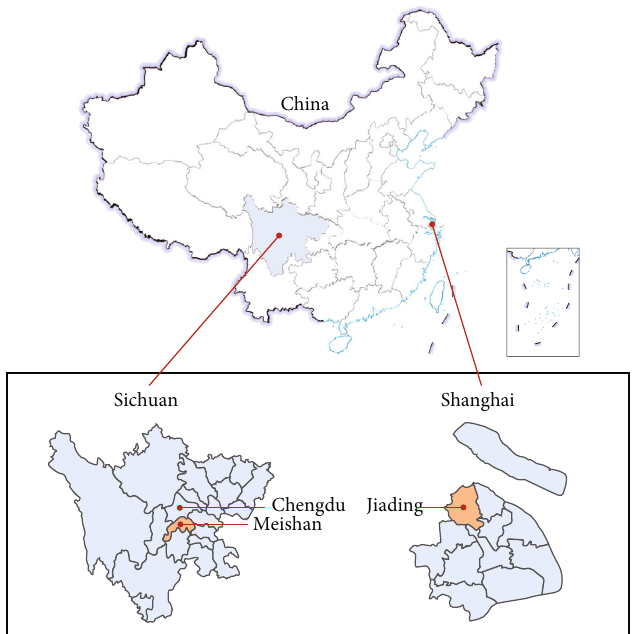
Figure 1: Location of Jiading and Meishan in